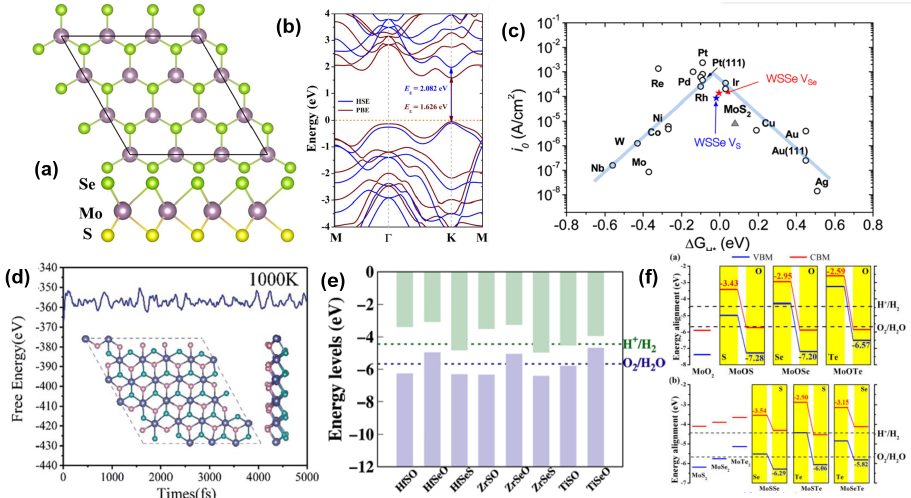
Figure 11. ( a ) Optimized crystal structures of Janus MoSSe monolayer from top and side views. ( b ) Band structures of MoSSe monolayer based on PBE and HSE06 functionals, respectively. Reproduced